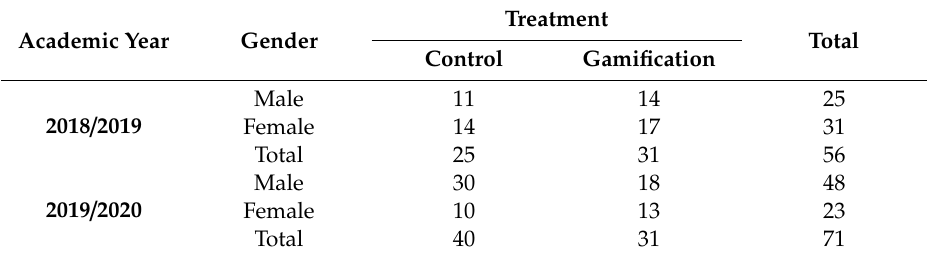
Table 1. Descriptive data of the sample ( n ) regarding year, gender and